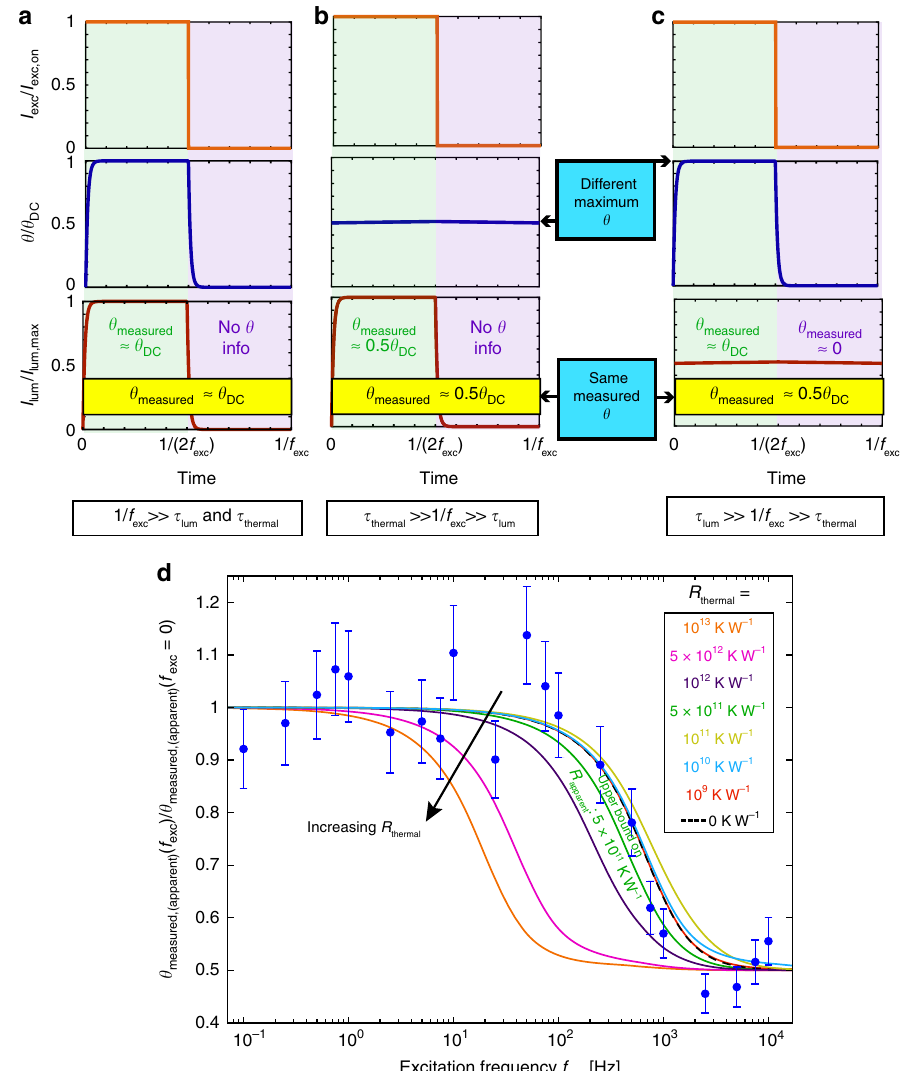
Fig. 6 Frequency-dependent ratiometric measurements. Complications when interpreting ratiometric thermometry results obtained with periodic laser excitation at higher frequencies. a When 1/ f exc ≫ τ lum and τ thermal , the temperature rise, θ , is a square wave between 0 and θ DC . Similarly, the luminescence intensity, I lum , is a square wave between 0 and I lum,max . Thus θ measured = θ DC is an average over the half cycle when I exc is on. b When τ thermal ≫ 1/ f exc ≫ τ θ . θ I lum , the steady-periodic temperature rise is nearly constant at 0.5 DC measured is again an average over the half cycle when exc is on, and thus here θ = 0.5 θ τ ≫ 1/ f ≫ τ θ is a square wave between 0 and θ I I θ measured DC . c If instead lum exc thermal , DC , but now lum is nearly constant at 0.5 lum,max . Now, measured represents an average over the full cycle. Thus once again θ measured = 0.5 θ DC , but for a completely different reason than the scenario in b . The inability to distinguish between these two cases leads to a loss in sensitivity to R thermal if τ lum > τ thermal . d Modeled temperature rise (lines) and experimental apparent temperature rise (points) as a function of excitation frequency for a single 50 × 50 × 50 nm 3 nanoparticle on an uncoated borosilicate